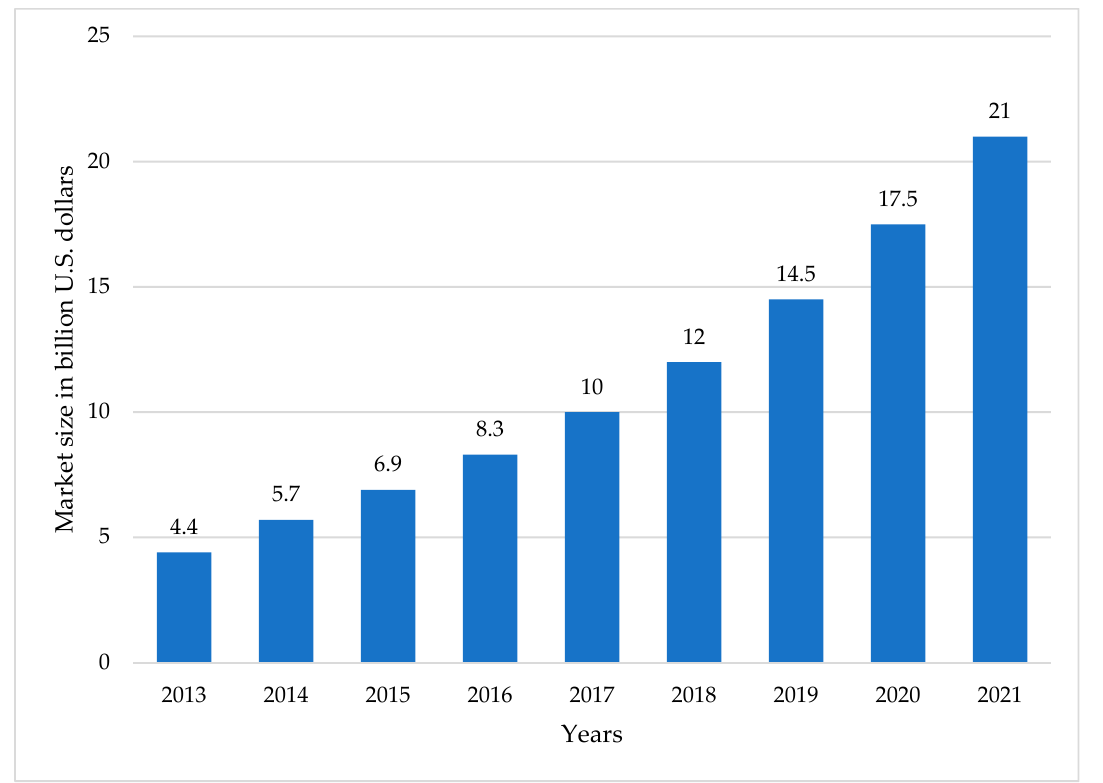
Figure 2. 3D printing market size worldwide, from 2013 to 2021.